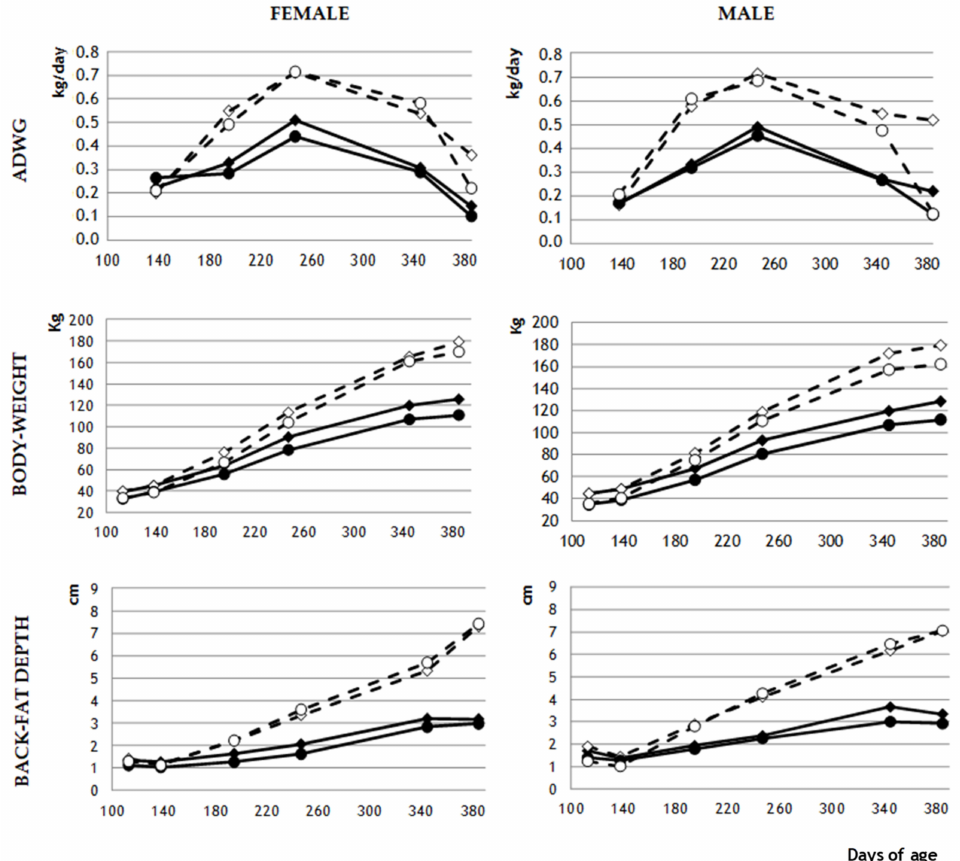
Figure 2. Mean values of average daily weight gain (ADWG; kg/day), body weight (kg) and back-fat depth (cm) in female and male pigs with normal birth weight (NBW; diamond marks) or low birth weight (LBW; circle marks) that were fed a maintenance diet (MD; continuous lines and filled marks) or a fattening diet (FD; discontinuous lines and empty marks). For clarity, SEM is not shown, but can be seen in Supplementary Table